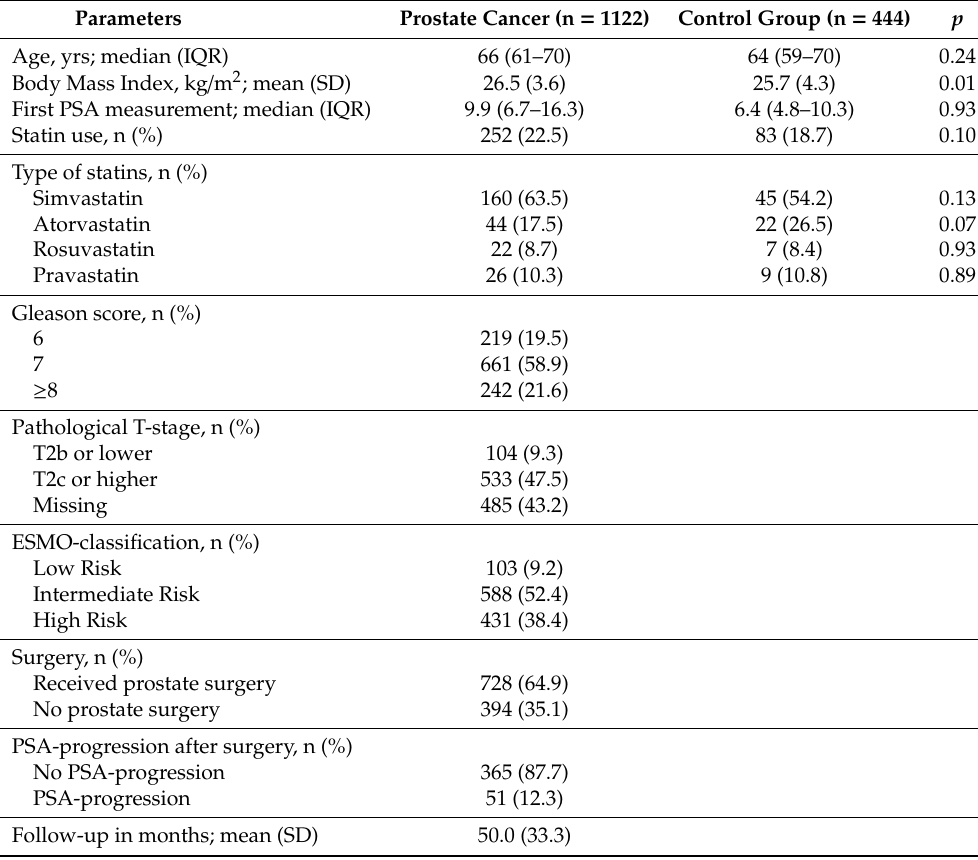
Table 1. Characteristics and outcomes of each cohort.